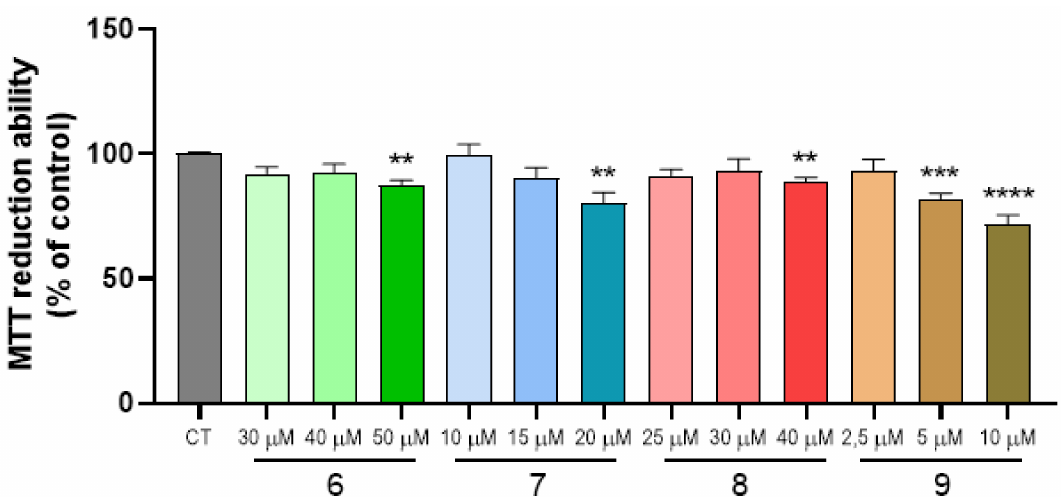
Figure 2. Dose-response screening of compounds 6–9 on SH-SY5Y neuronal cell line. SH-SY5Y cells were treated with varying concentrations of compounds from 2.5 µ M to 50 µ M for 24 h and cellular viability was measured by using the MTT reduction assay. Results are expressed relatively to SH-SY5Y untreated cells, with the mean ± SEM derived from at least three different experiments. ** p < 0.01, *** p < 0.001, **** p < 0.0001 significantly different when compared with control, untreated SH-SY5Y